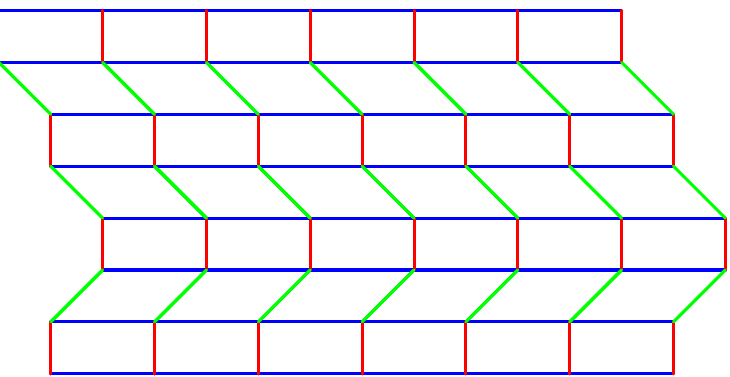
Fig. 34: A pair of opposite edges in the vertex corona are of the same length and there are two different tiles. Then the tiles are parallelograms. (NC) if one of the parallelograms is a rectangle.